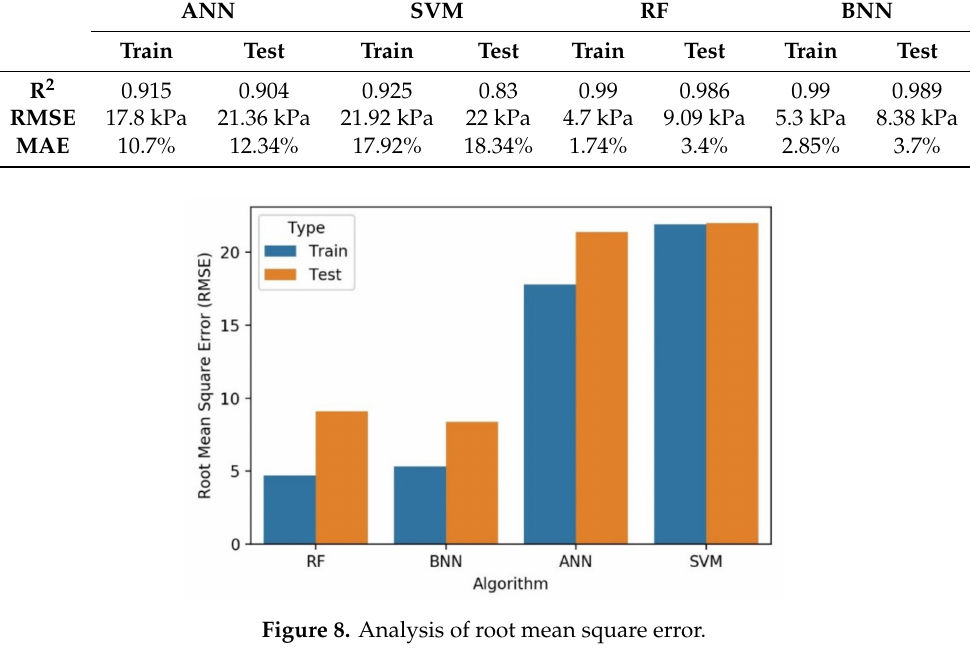
Table 4. Summary of metrics to evaluate performance of ANN, BNN, SVM, and random forest (RF). ANN